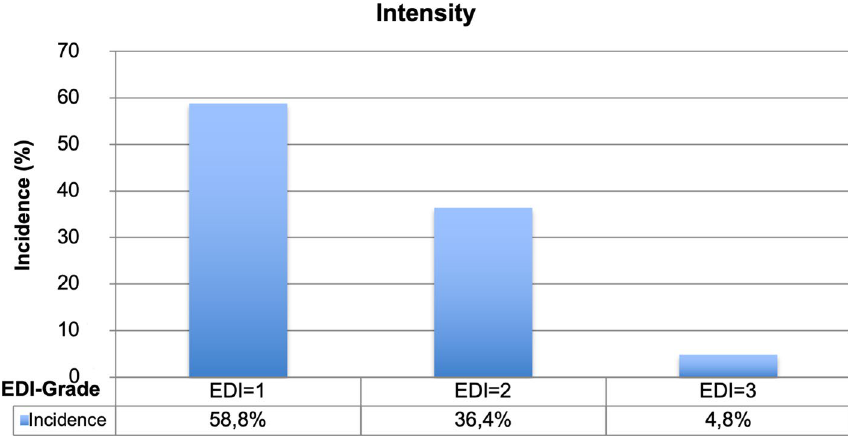
Figure 6. Incidence distribution based on intensity (EDI).